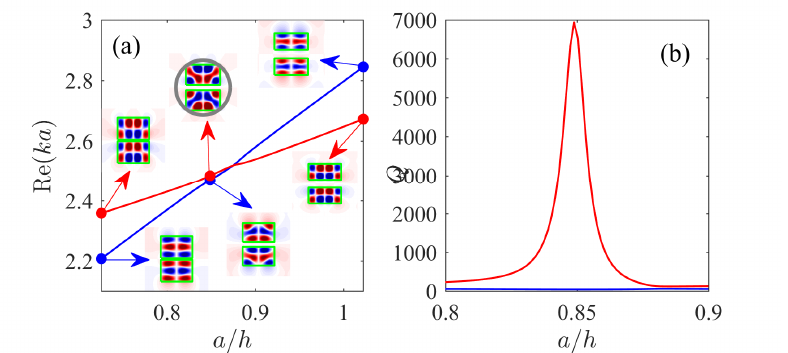
Figure 9. Evolution of the TM resonances ( a ) and Q factor ( b ) in traversing with the height of the disks at L / a = 1.48. Insets shows profiles of the TM resonant modes H φ .